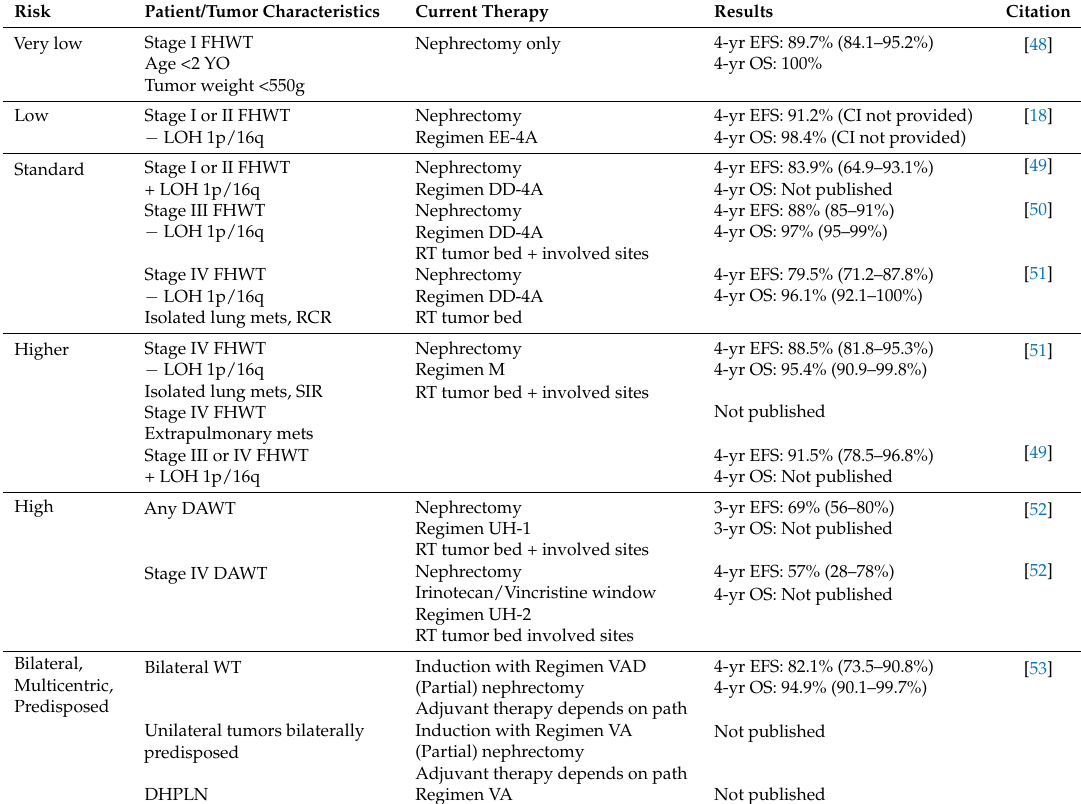
Table 2. Current risk stratification, treatment regimens, and